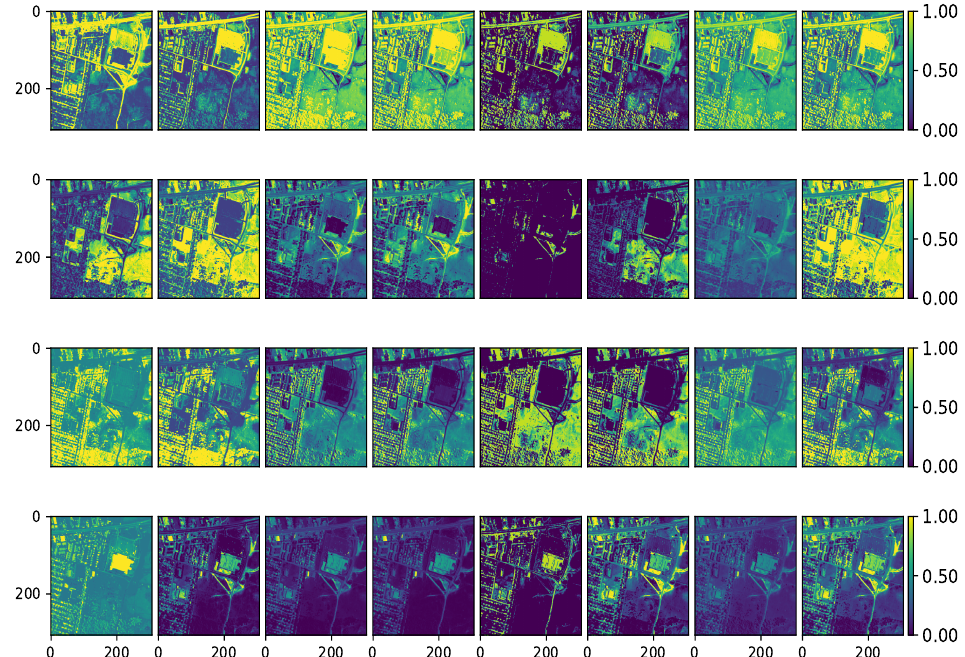
Figure 11. Estimated abundance maps of Urban dataset. From left to right: VCA-K-Hype, N-FINDR- NDU, rNMF, DAEN, CYCUNET, Pixel-based DCAE, Modified Pixel-based DCAE and the proposed method, respectively. From top to bottom: Asphalt, Dirt,Tree, and Roof, respectively.